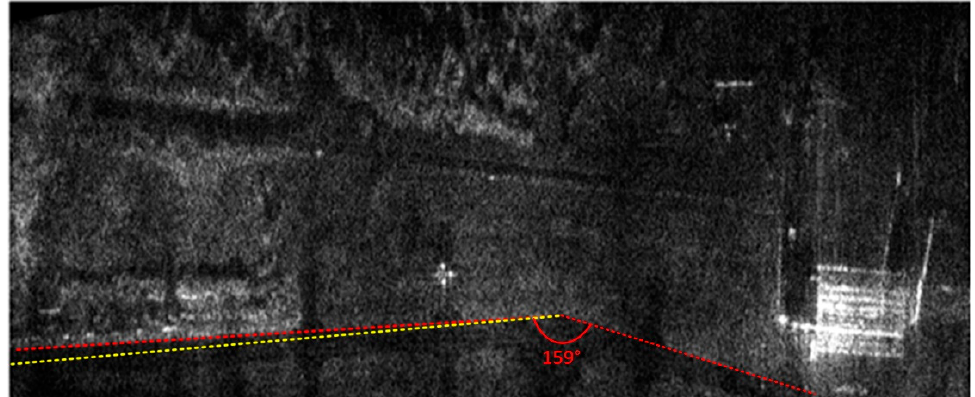
Figure 10. Radar terrain image obtained with the use of INS/GPS data; yellow line—a north edge of the taxiway determined using INS-based image, red line—a north edge of the taxiway determined using INS/GPS-based image.